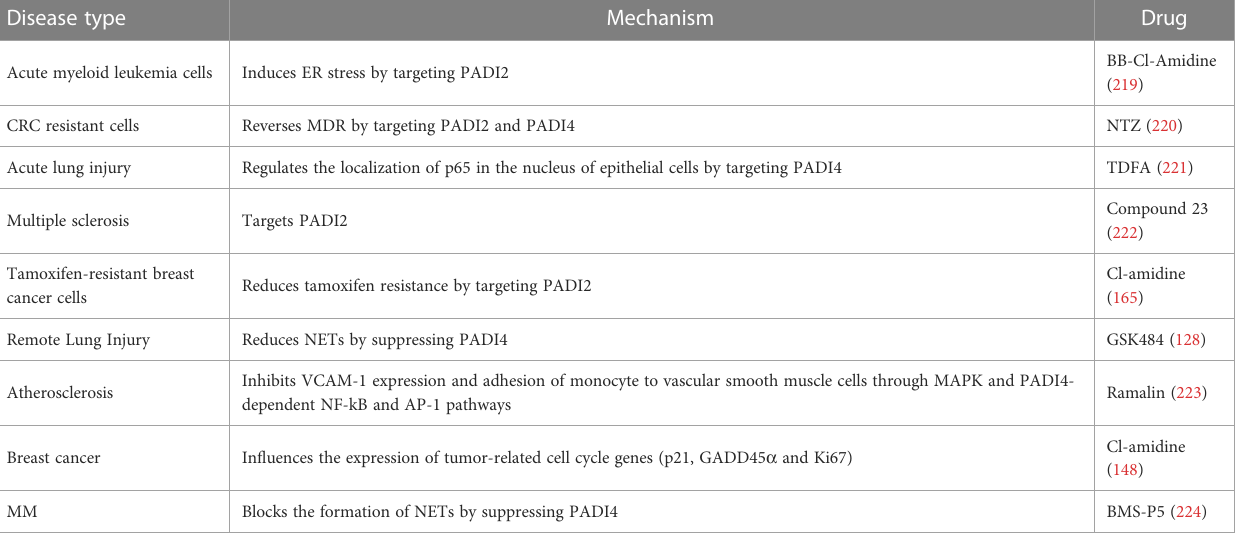
TABLE 3 Application of the PADI family in disease treatment. Disease